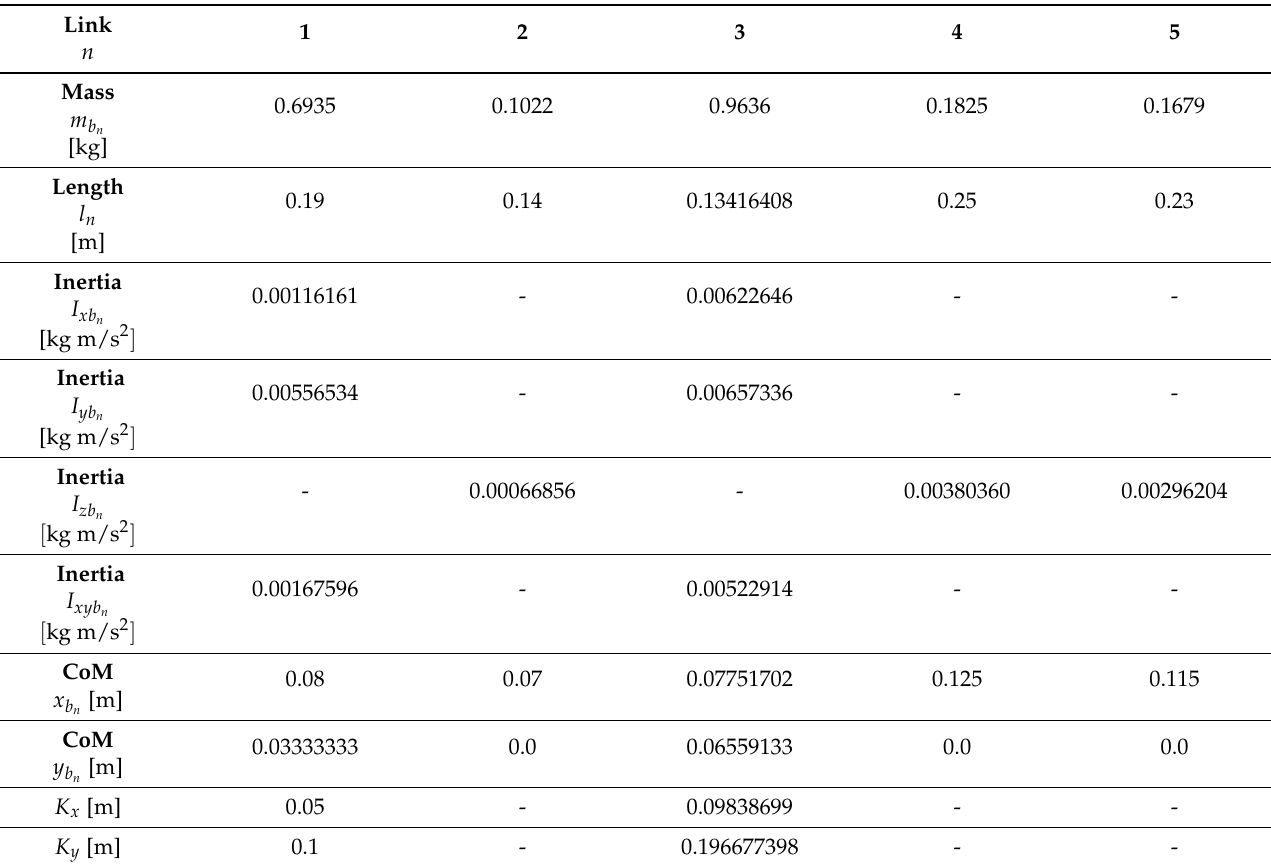
Table 2 summarizes the physical parameters of the six-bar mechanism shown in Figure 2. Steel links have been considered with a density of 7800 kg/m 3 . The counter- weights are considered to be made of brass with a density ρ cn = 8500 kg/m 3 . Table 2. Parameters of the six-bar mechanism used in the example. Those indicated with a ‘-’ are not necessary for the numerical